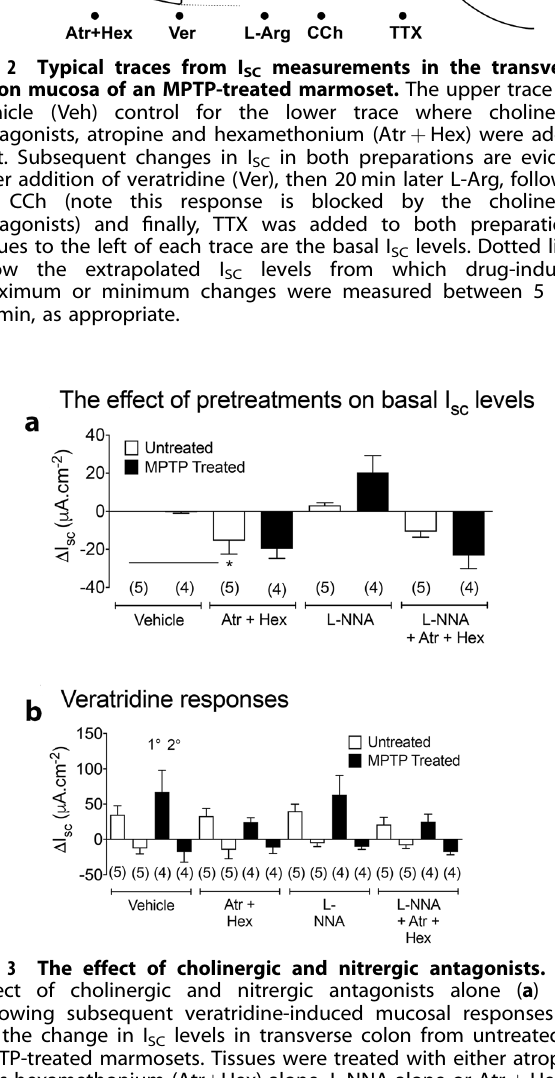
(ANOVA and Dunnett ’ s test).